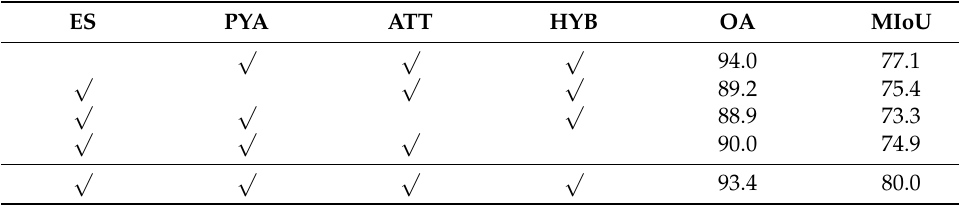
Table 5. Effects of each component on the segmentation